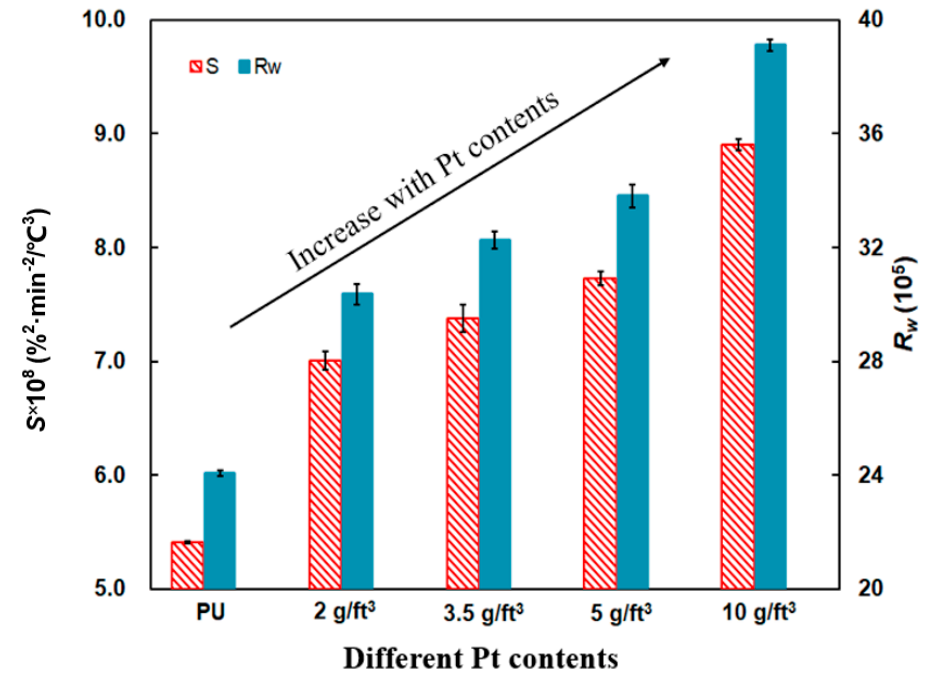
Figure 8. Comparison of the S and R w indices of PU/Pt mixtures at different Pt contents.